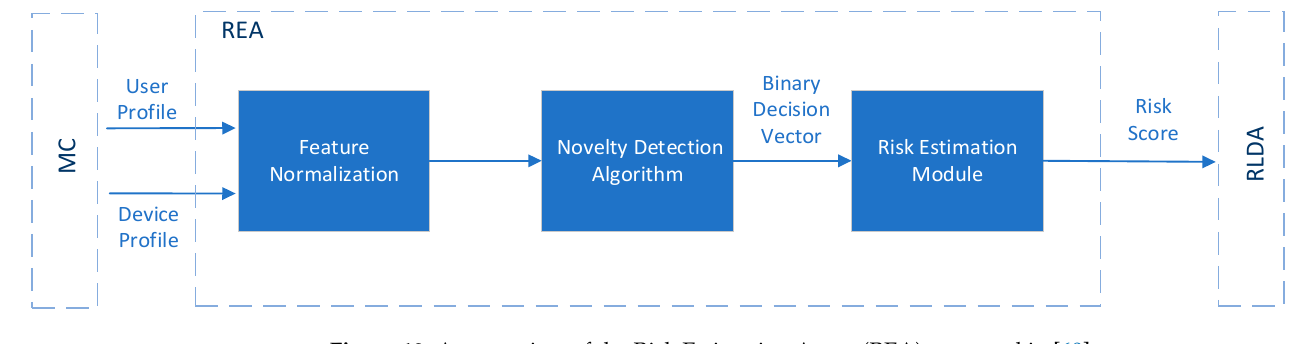
Figure 10. An overview of the Risk Estimation Agent (REA) proposed in [60].